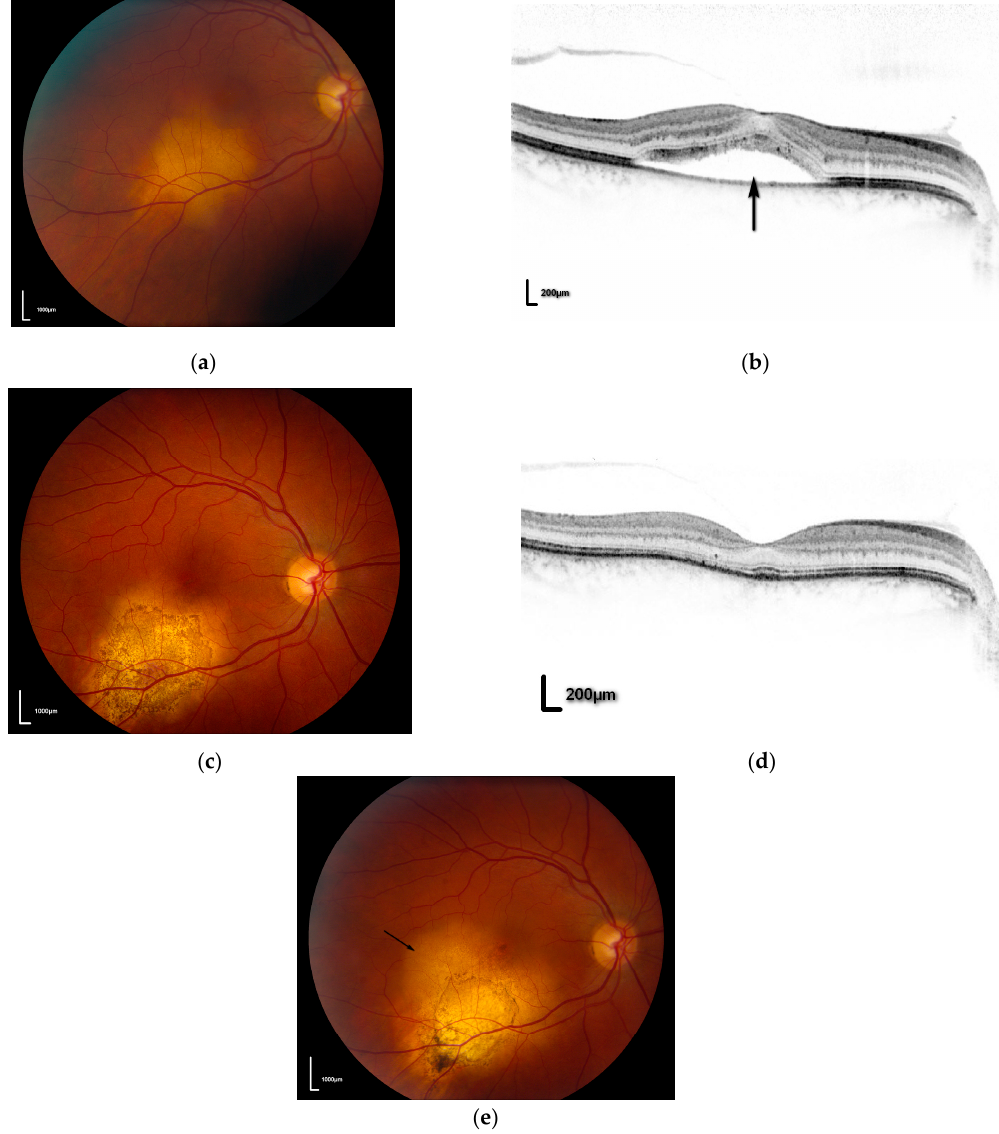
Figure 2. ( a ) pre-treatment fundal photograph of right eye demonstrating metastasis; ( b ) OCT scan demonstrating fluid beneath the fovea ( black arrow ); ( c ) post-PDT photograph showing regression of metastasis; ( d ) post-PDT OCT scan showing resolution of fluid; ( e ) fundal photograph showing recurrent tumour at edge of treatment scar ( black arrow ).